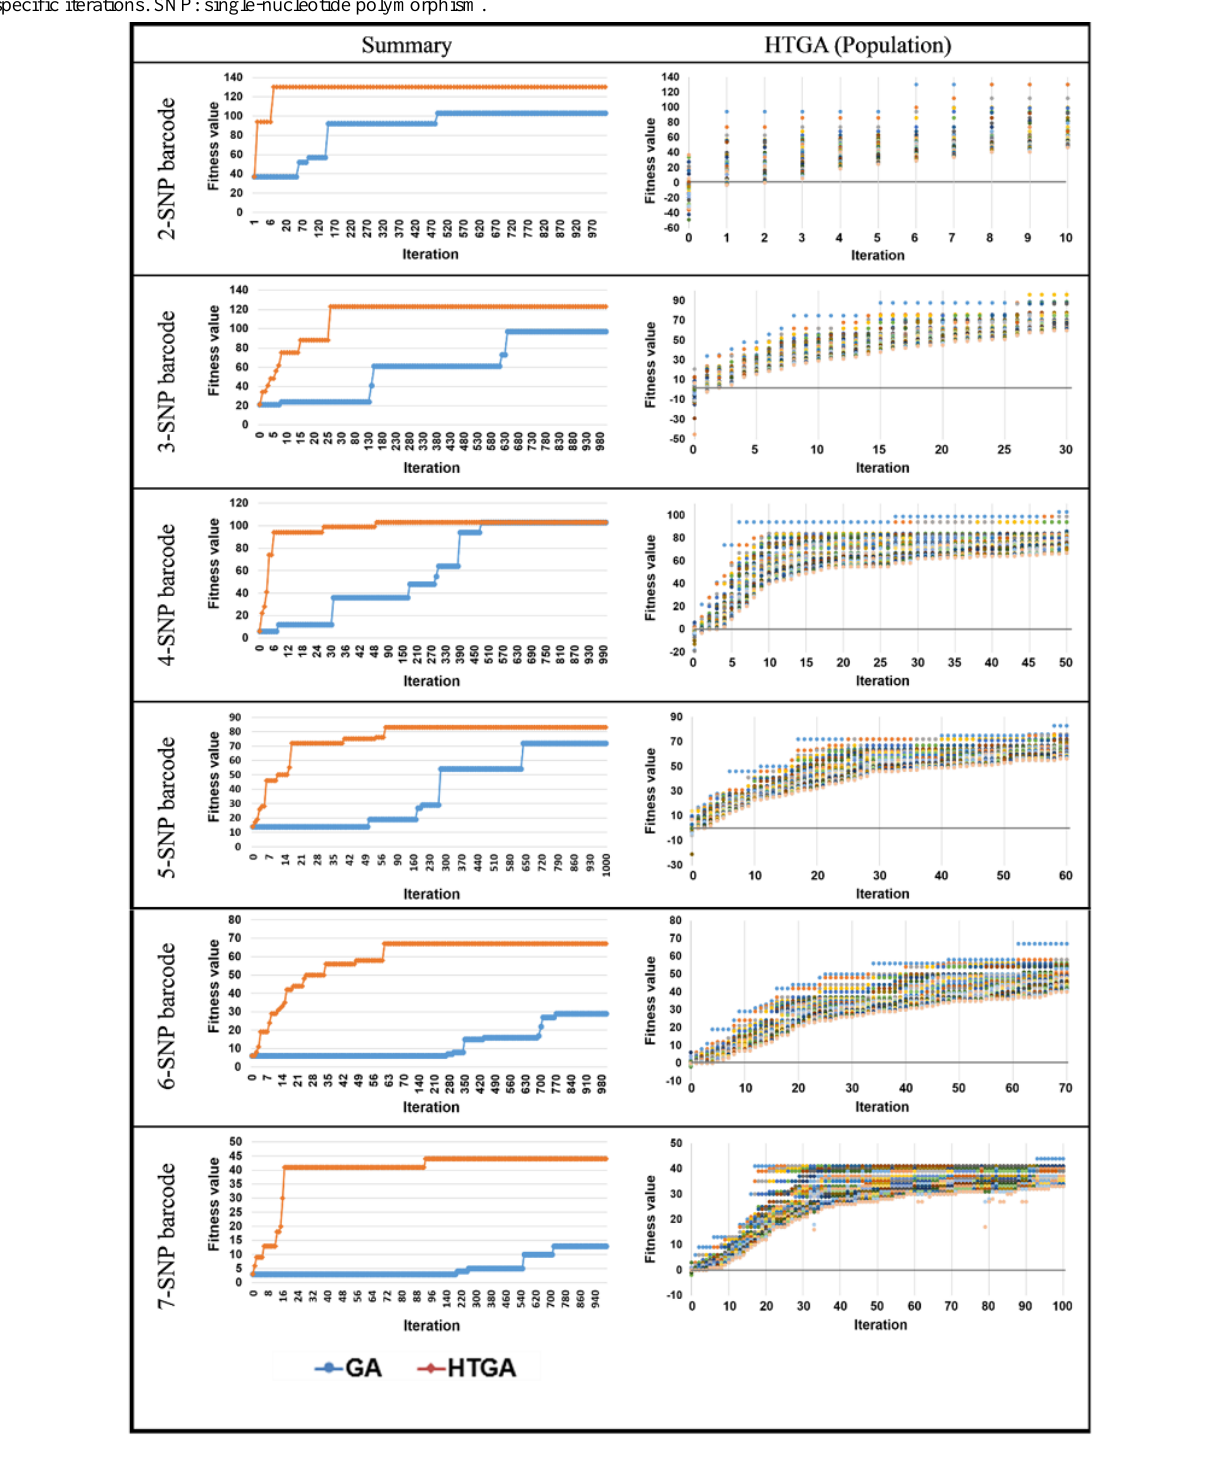
Figure 2. Comparison of improvements to fitness values between the genetic algorithm (GA) and hybrid Taguchi-genetic algorithm (HTGA).The images on the left compare GA and HTGA search results for 1000 iterations. The images on the right present the fitness values of an HTGA population at specific iterations. SNP: single-nucleotide